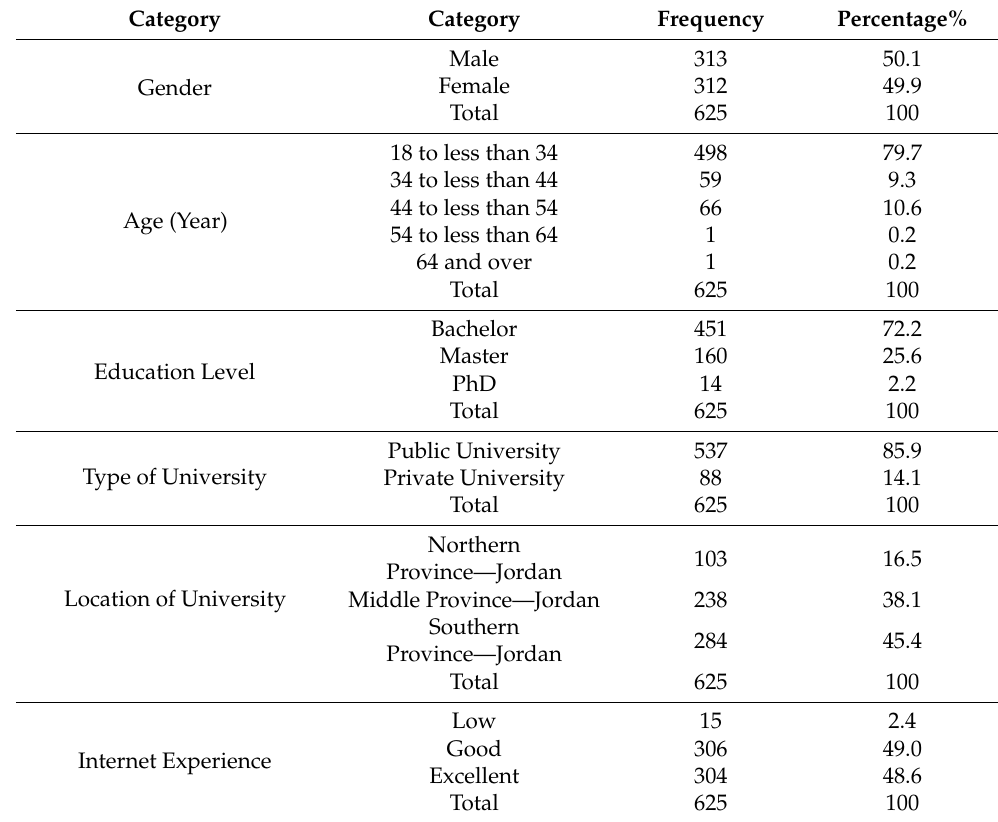
Table 1. Description of the respondents’ demographic